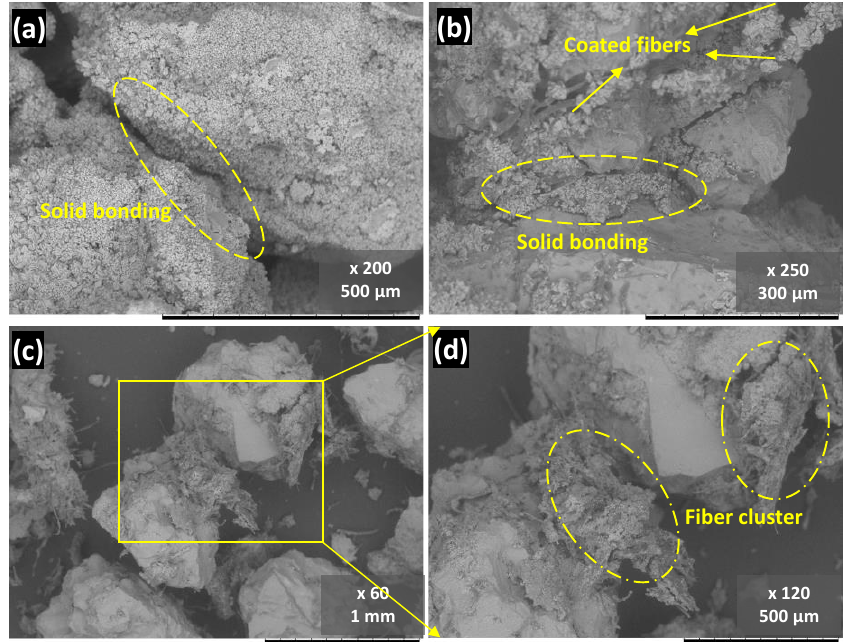
Figure 12. SEM images of representative treated samples after 25 FT cycles: ( a ) 0%; ( b ) 1%; and ( c , d ) 8% fiber content.